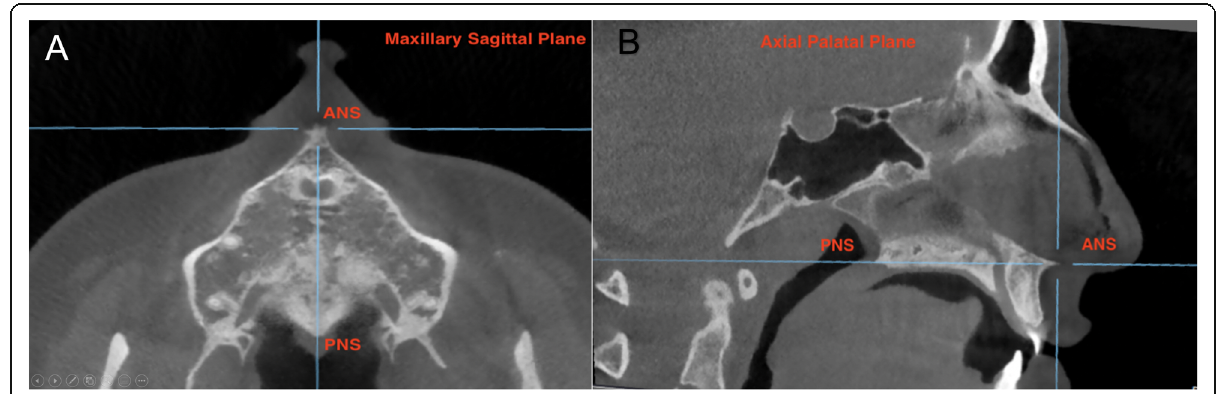
Fig. 5 a Axial cut shows the maxillary sagittal plane. b Axial palatal plane passing through anterior nasal spine (ANS) and posterior nasal spine (PNS). Blue lines represent reference